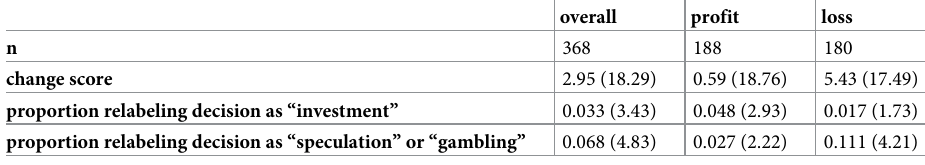
Table 8. Change scores and proportions relabeling decision by outcome.